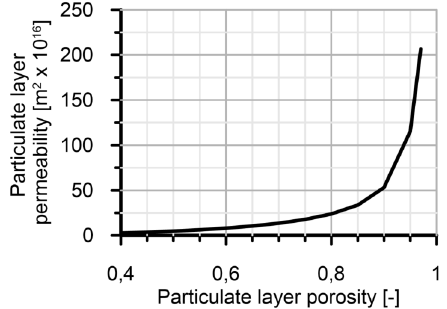
Figure 8. Particulate layer permeability as a function of the